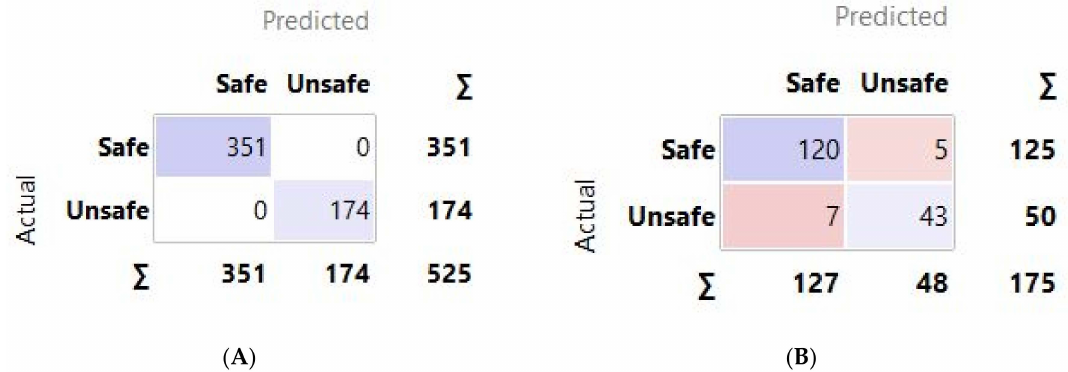
Figure 9. The AdaBoost model results for FOS classification: ( A ) Training and ( B )